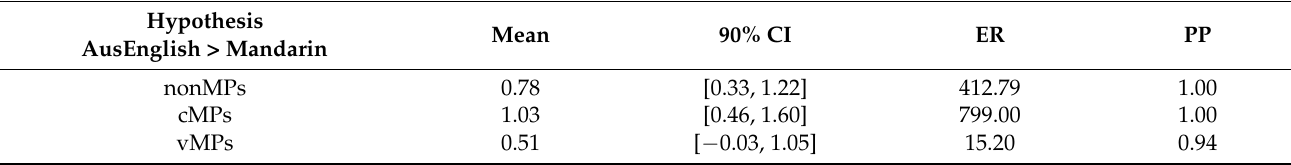
Table 2. Hypothesis test results for the evidence ratios of the second accuracy models’ interaction between pair type and language